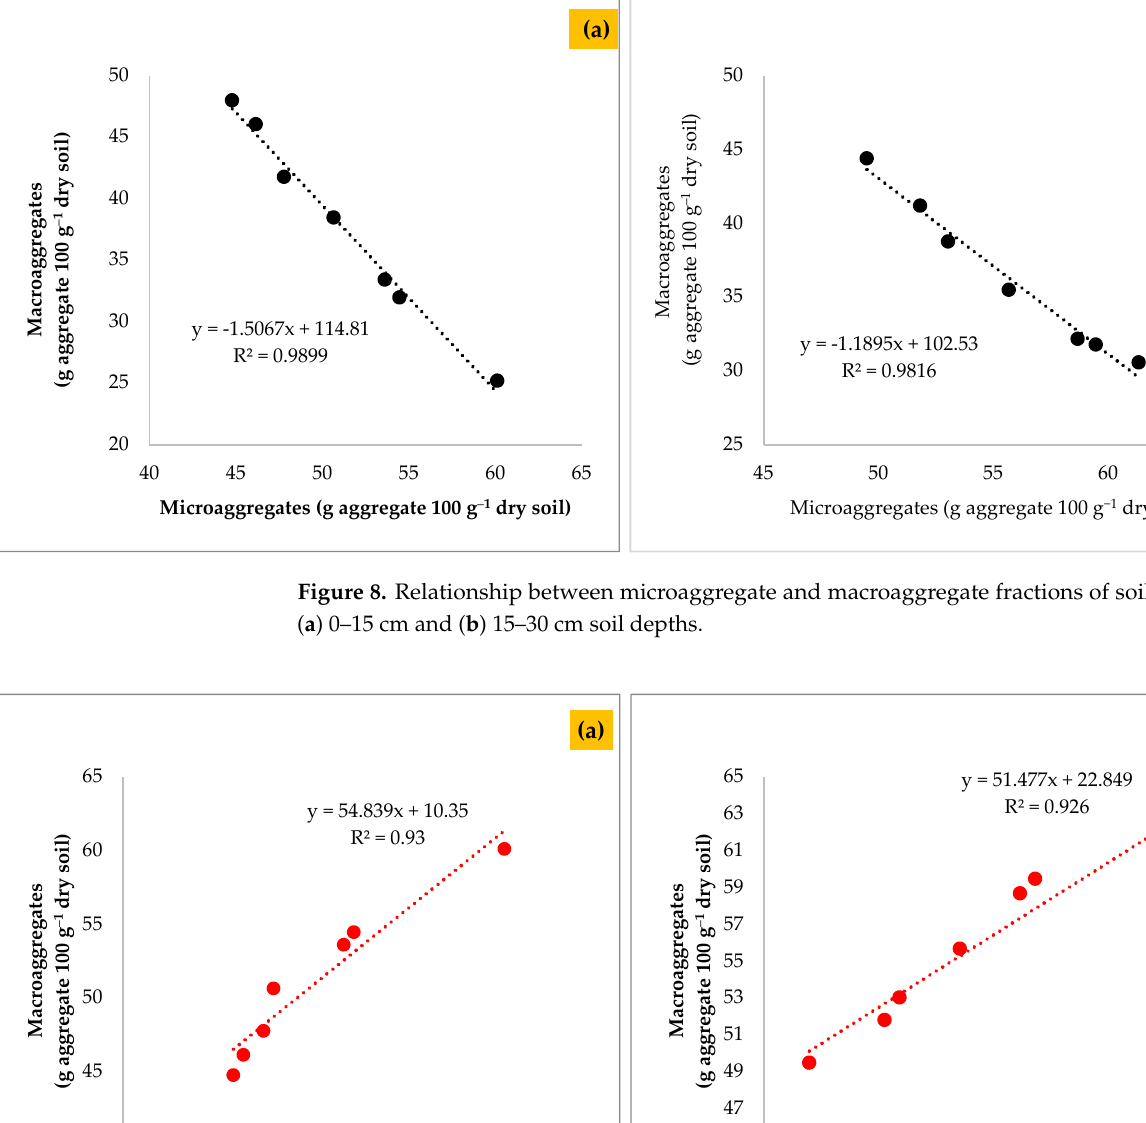
ten been used as indices of soil sustainability. Results showed that macroaggregates were significantly negatively correlated with microaggregates (R 2 = 0.99, p < 0.01; Figure 8a) in 0–15 cm soil depth and in 15–30 cm soil depth (R 2 = 0.98, p < 0.01; Figure 8b). The regression lines for macroaggregates versus microaggregates showed a negative linear relationship (macroaggregate = − 1.5067x + 114.81 and − 1.1895x + 102.53) in the 0–15 and 15–30 cm soil depth.